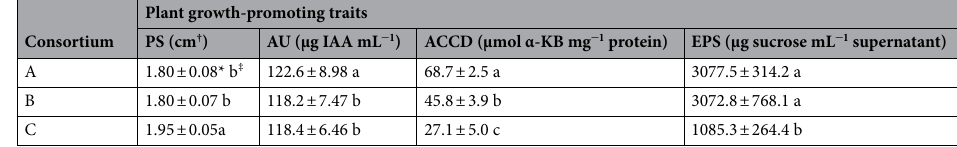
Table 2. Plant growth-promoting traits in rhizobacterial consortia from Cistanthe longiscapa . PS phosphate solubilization, AU production of tryptophan-induced auxins, ACCD 1-aminocyclopropane-1-carboxylate deaminase activity, EPS exopolysaccharides production, IAA indole acetic acid, KB α-ketobuty rate. *Values represent the means ± standard deviation of n = 3. † Ratio is calculated as clear halo diameter/colony diameter of phosphate solubilization. ‡ Different letter in each column denote significant differences ( P ≤ 0.05) by ANOVA followed by Tukey’s post-hoc test.